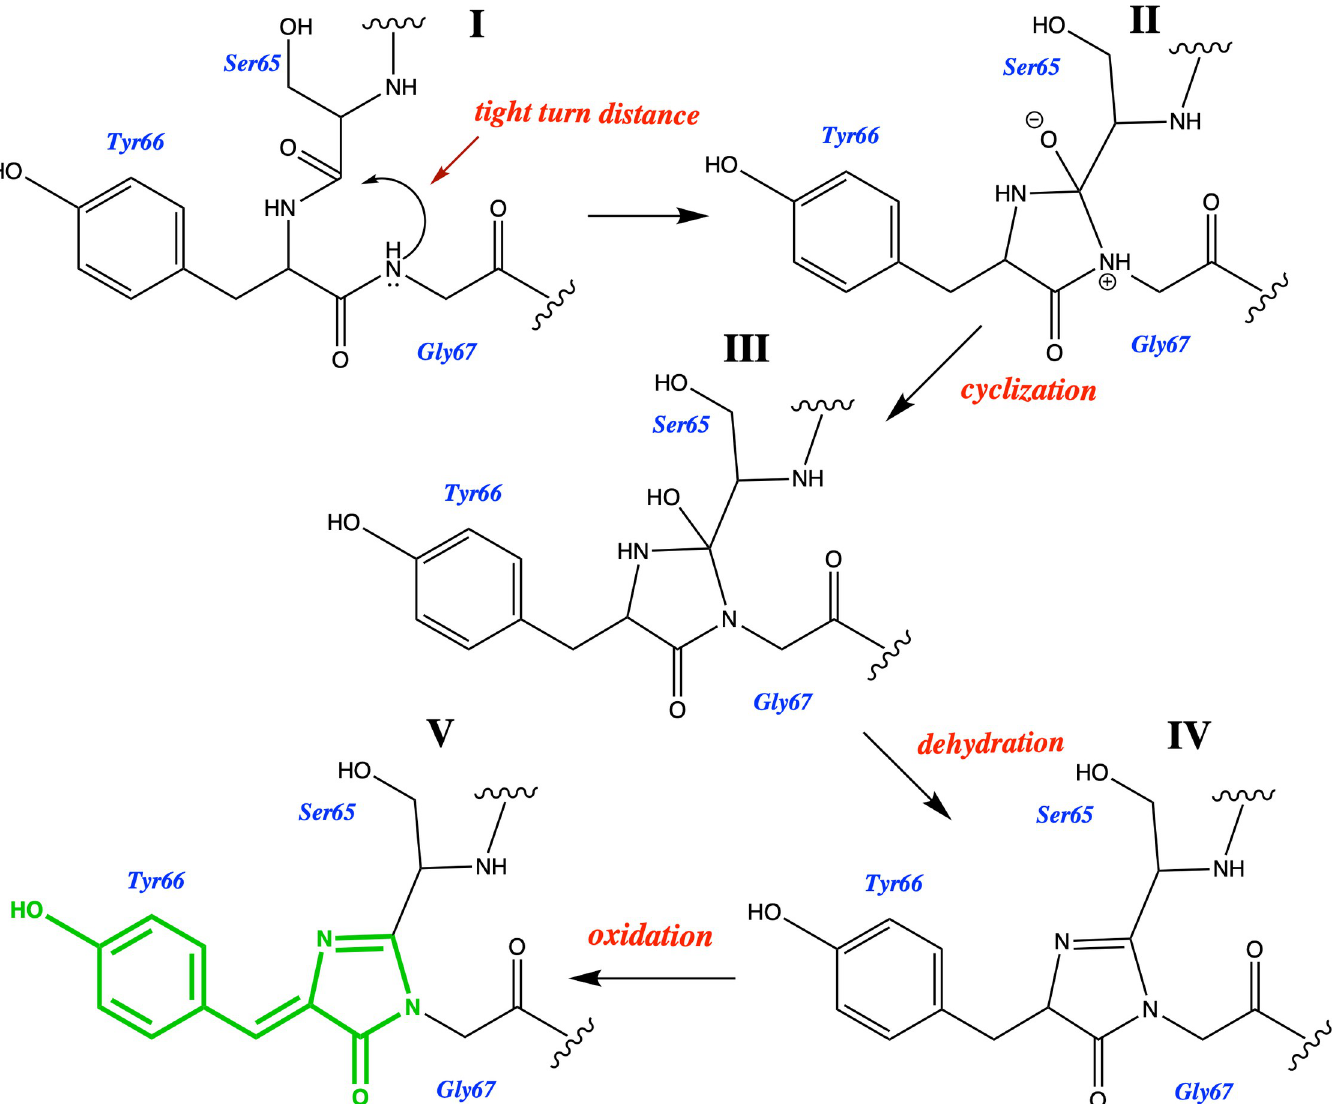
Fig 1. The cyclization-dehydration-oxidation pathway for chromophore formation. [26] Structure I is known as the immature precyclized form of the protein. The tight-turn distance depicted in structure I was measured for all sequences and is presented in S1 Data. Structure V shows the fully formed mature chromophore (green).